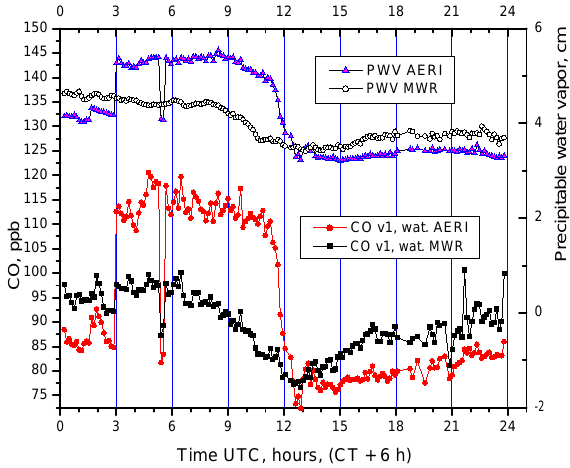
Fig. 4. An example of AERI-derived PWV compared with MWR- derived PWV (top two curves). The bottom two curves are individ- ual CO retrievals with input water vapor profiles from AERI spec- tra (red) and AERI-derived water vapor profile scaled using MWR PWV